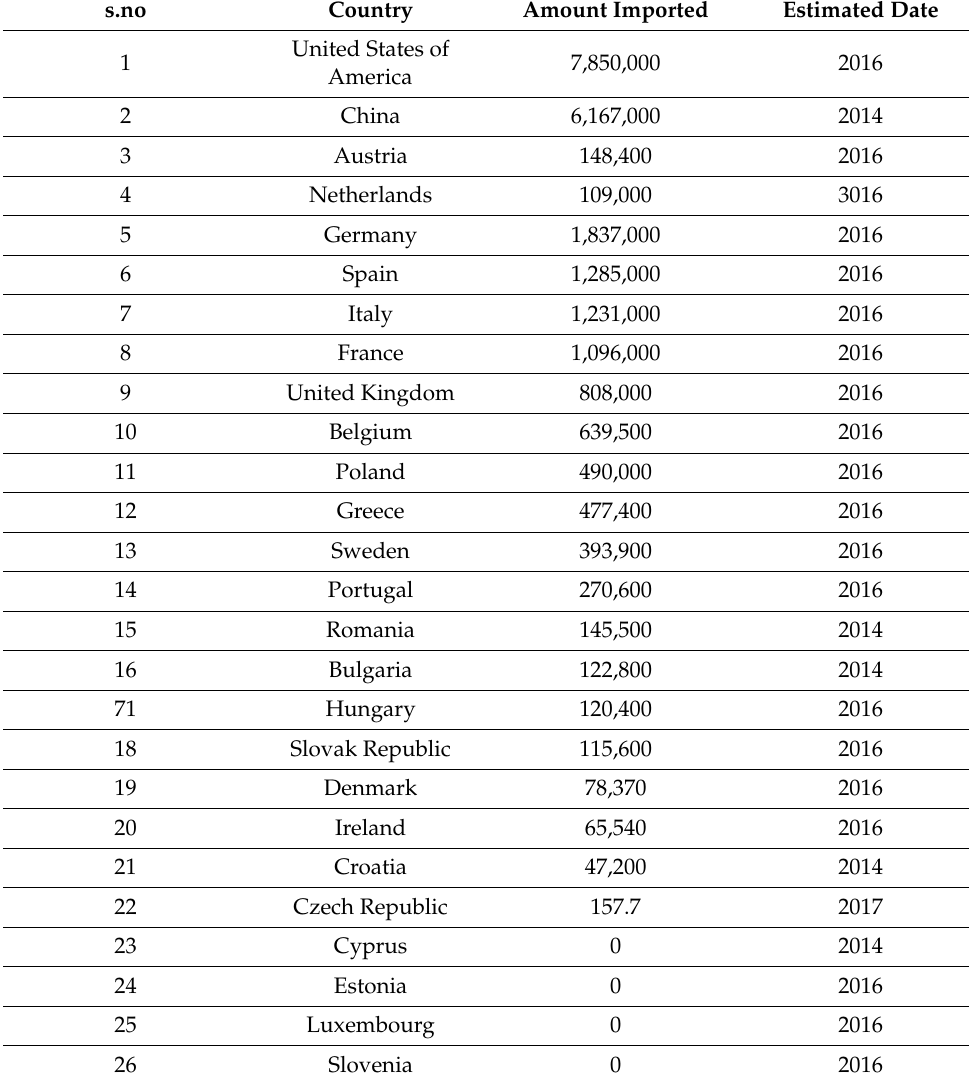
Table A3. Crude oil imports is the total amount of crude oil imported, in barrels per day